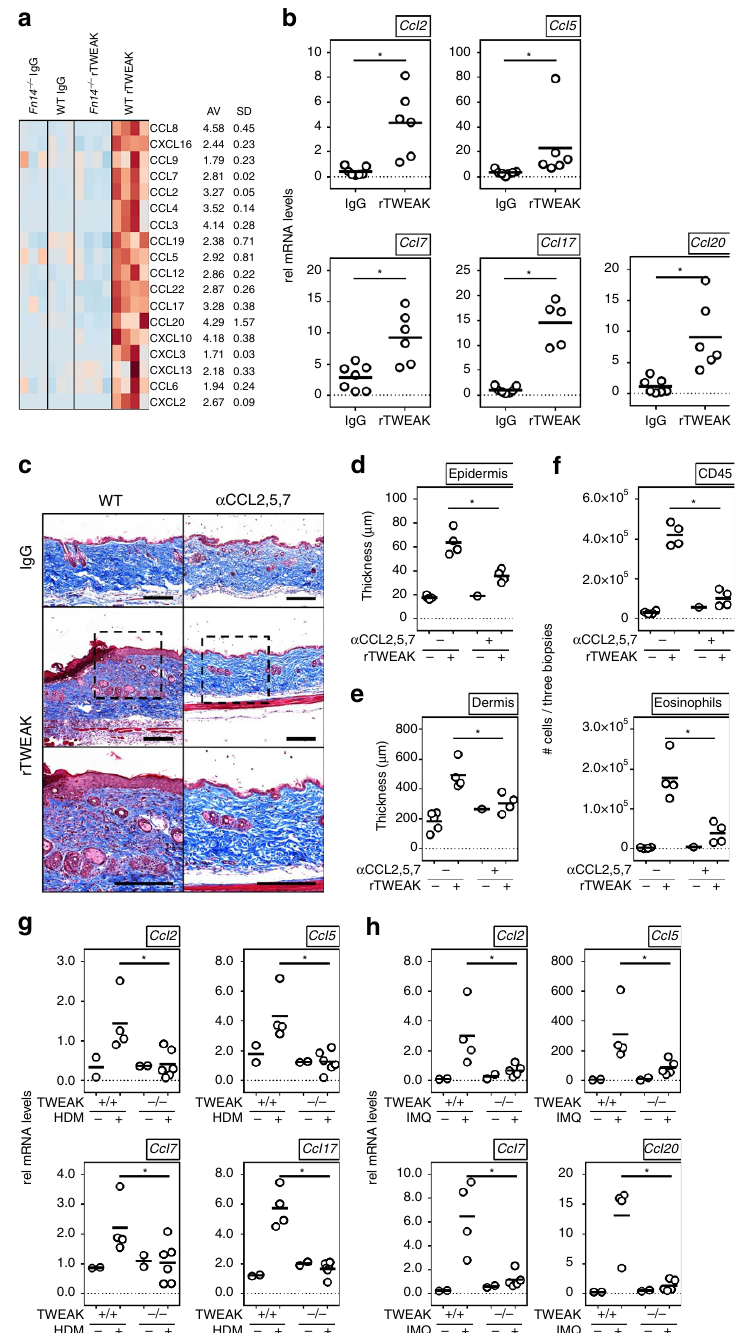
Figure 4 | TWEAK regulates chemokine expression in the skin. ( a , b ) Naive WTor Fn14-deficient mice were injected with rTWEAK or IgG, administered once s.c. After 4 days expression of mRNA for indicated chemokines was measured in skin biopsies. ( a , left) RNAseq heatmap of chemokine expression from 3 to 4 animals/group. (right) Mean (AV) fold increase and SD calculated from RNAseq data of the comparisons of rTWEAK into WT versus Fn-deficient mice, rTWEAK versus IgG into WTmice, and rTWEAK versus no injection into WTmice. ( b ) qPCR mRNA expression of indicated chemokines relative to GAPDH. Combined results from two experiments. Each data point one mouse. ( c – f ) naive WT mice were injected with rTWEAK or IgG (s.c.) twice weekly over 14 days as in Fig. 3a, with either a combination of blocking antibodies to CCL2, CCL5 and CCL7, or a combination of control antibodies (i.p). Combined results from two experiments. ( c ) Masson’s trichrome staining of representative skin sections. Scale bar, 200 m m. ( d , e ) Quantification of epidermal and dermal thickness. ( f ) Total numbers of CD45 þ cells and SigF þ CD45 þ CD11b þ Ly6G (cid:2) eosinophils from skin biopsies. ( g , h ) WT and TWEAK-deficient animals were treated with HDM for 23 days ( g ) and IMQ for 8 days ( h ) and mRNA for indicated chemokines assessed in skin, relative to GAPDH expression. Combined from two experiments. Each data point one mouse. Bars represent mean values. The Mann–Whitney U -test was performed to compare the groups. Asterisks indicate P o 0.05. qPCR, quantitative PCR.